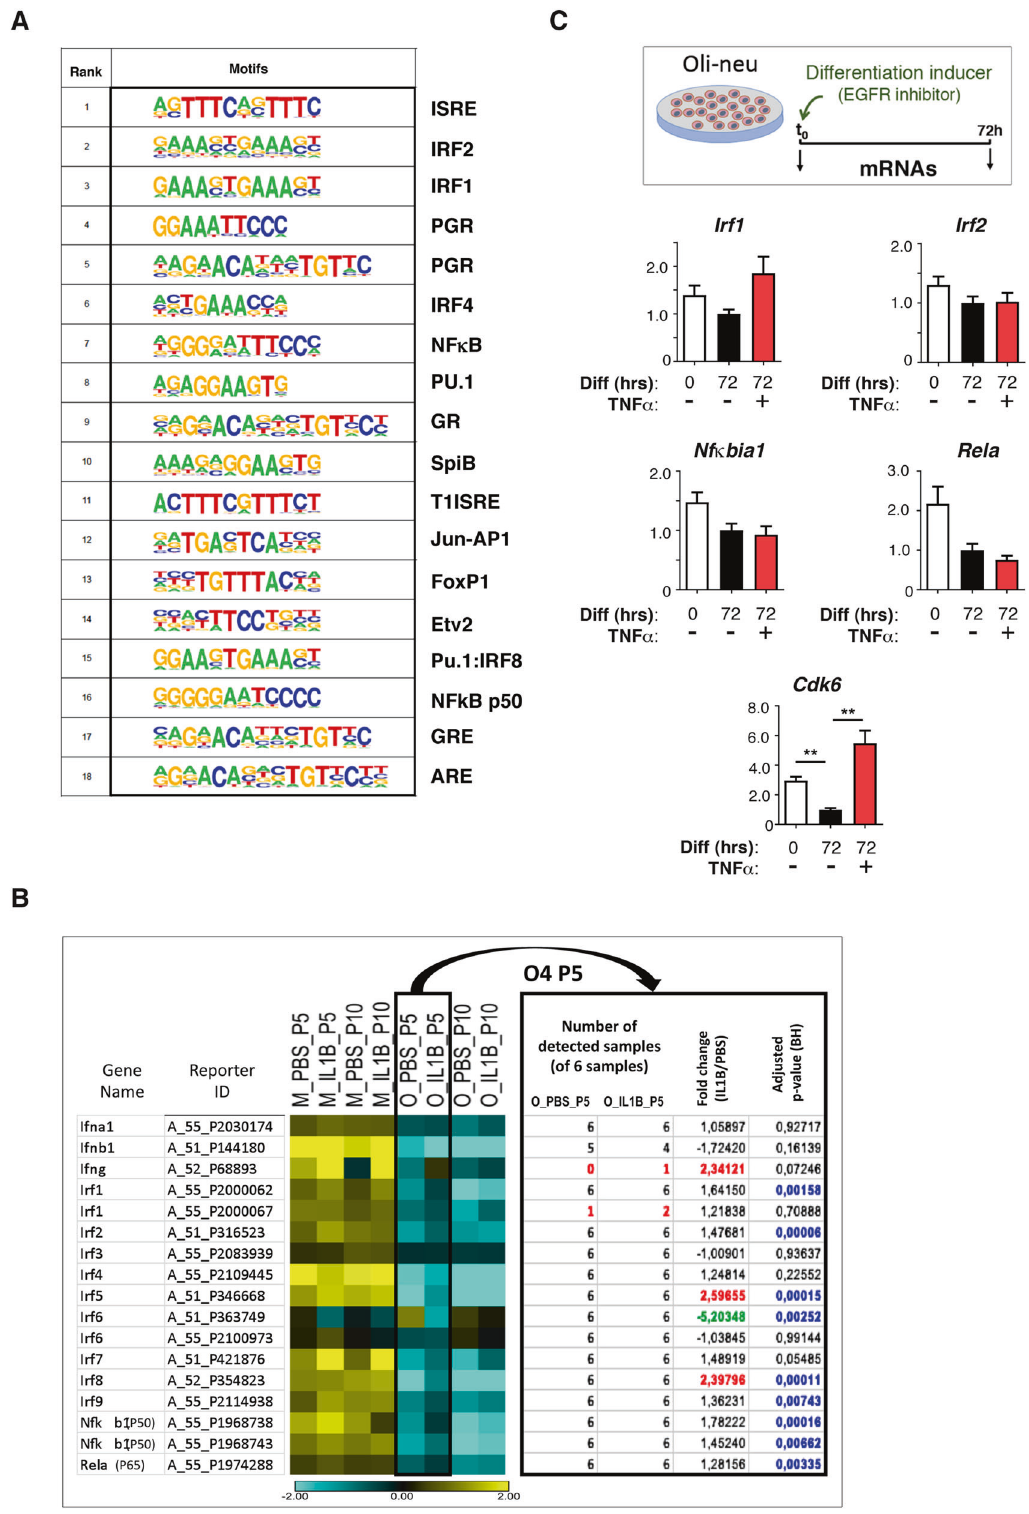
Fig. 6 TFBS motifs identi fi ed in signi fi cant ATAC-seq peaks associated with cluster C1 genes and expression of the corresponding TF genes in O4 + cell populations and the Oli-neu cell line. A TFBS motif analysis reveals the presence of TF binding motifs of the immune/ in fl ammatory pathways in signi fi cant ATAC-seq peaks that are adjacent to the upregulated genes (UP) correspond to TF of gene cluster C1. TFBS were identi fi ed using HOMER known motifs. (See also Fig. S5). B Heat map illustrating the expression of TFs of the IRF and NF κ B families in O4 + cell populations. Microarray data from microglia [9]; n = 3 PBS samples and n = 3 IL1B samples isolated from the same cortices and at the same stage is given for comparison. M: Microglia. O_P5: O4 + cells at P5. O_P10: O4 + cells at P10. C The oligodendroglial Oli-neu cell line recapitulates the expression of TF genes of the immune/in fl ammatory pathways in physiological and in fl ammatory conditions. As in Fig. 4C. Cyclin-dependent kinase 6 ( Cdk6 ) mRNA levels were analyzed in parallel. Cell Death and Disease (2022)